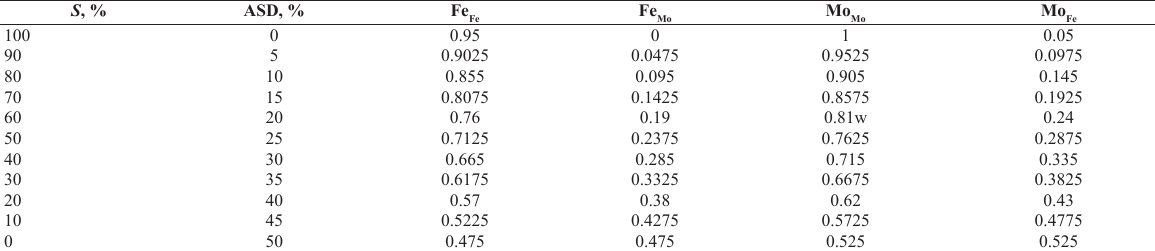
Fe Mo O sublattices. 2 0.95 1.05 6-δ